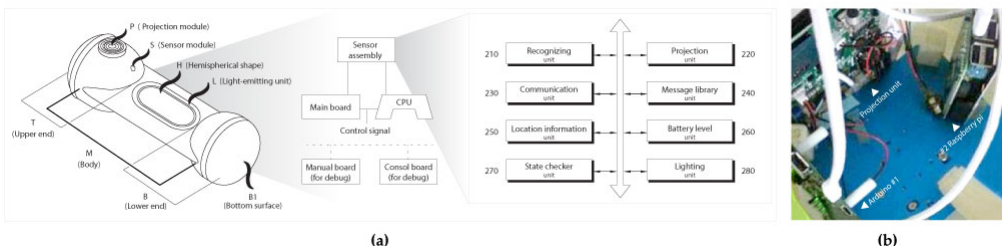
Figure 7. The architecture of the sensor robot system: ( a ) controlling module with the sensor assembly; ( b ) implemented projection unit.